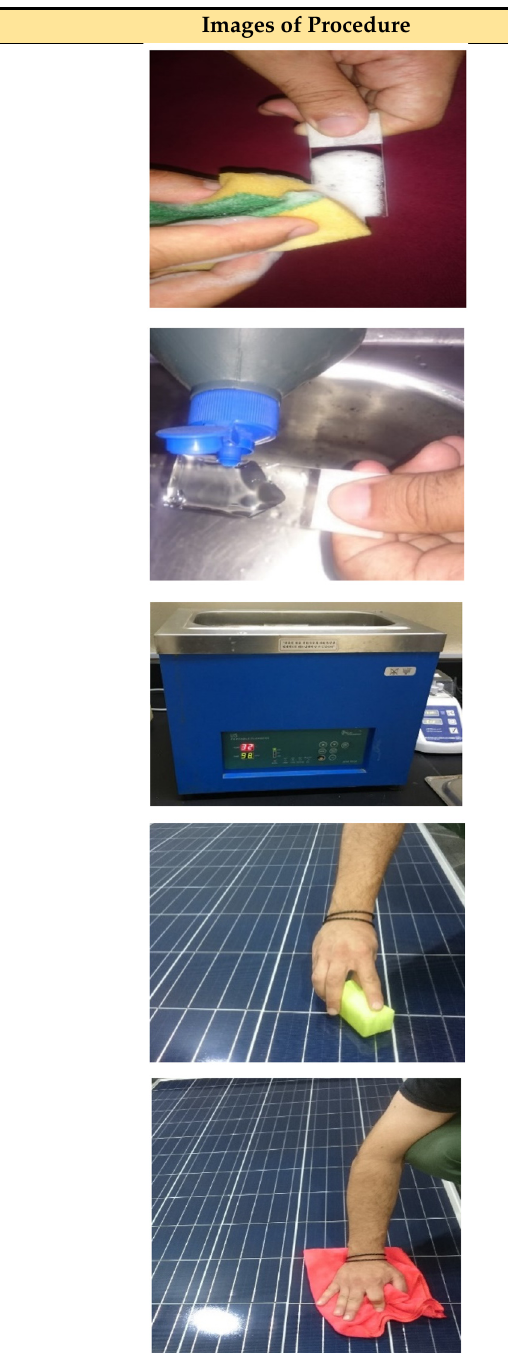
Table 2. Test samples coating